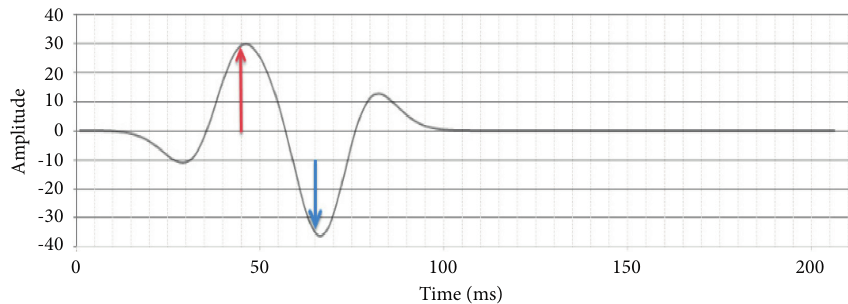
Figure 18: Synthetic seismic records obtained based on Figure 16.